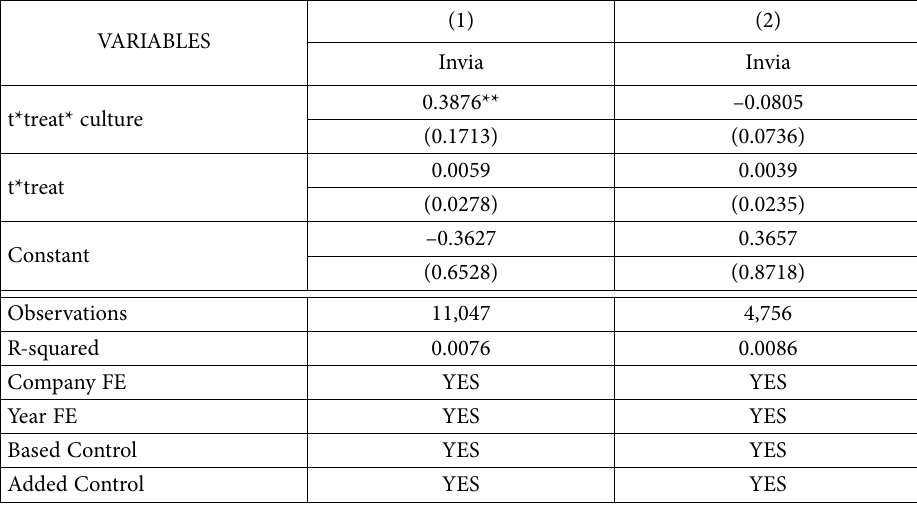
Table 6. Eastern coastal and inland